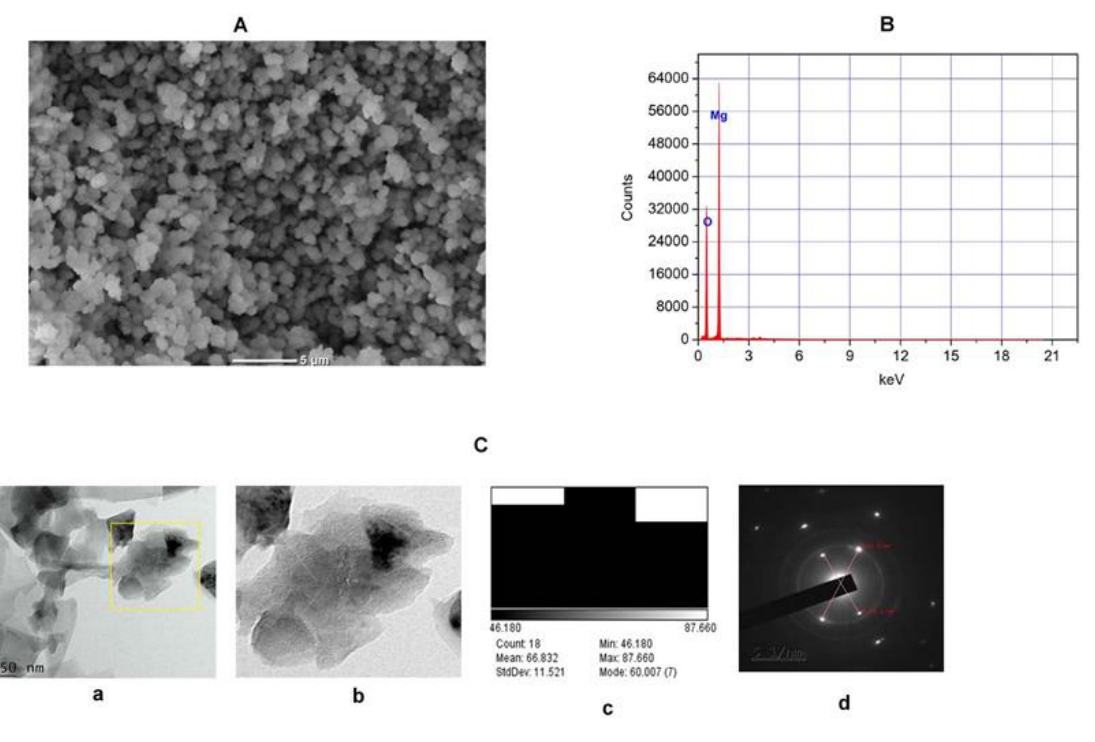
Figure 2. ( A ) SEM microgram of TAFEMgO NPs. The SEM micrograph of TAFEMgO NPs was depicted with scale bar 5 µ m. ( B ) ED x-ray diffraction (EDX) reveals high elemental composition with Mg and O, showing high purity with mass% of 33.70 and 66.90, respectively, and 1.253 and 0.525 are the keV of TAFEMgO NPs, respectively, confirm the formation of MgO NPs. ( C )